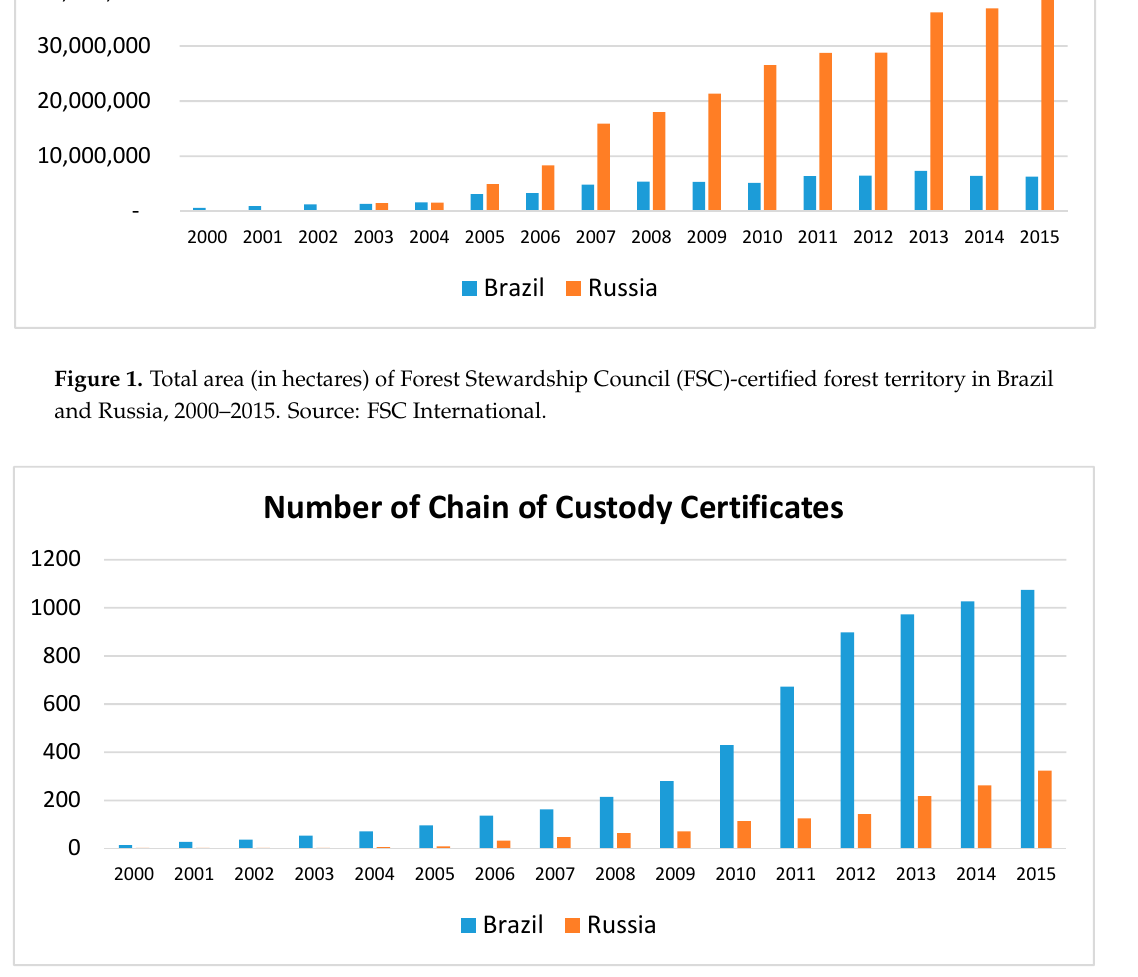
Figure 2. Number of FSC chain of custody certificates granted in Brazil and Russia, 2000–2015. Source: FSC International.